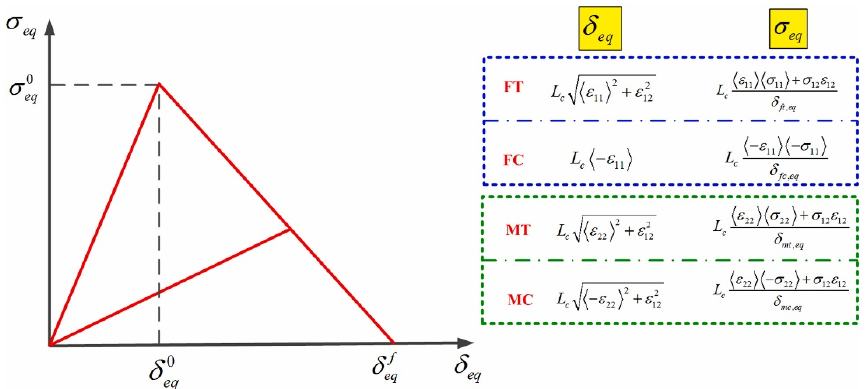
Figure 6. The constitutive relationship of composite materials in the 2D Hashin model [16].